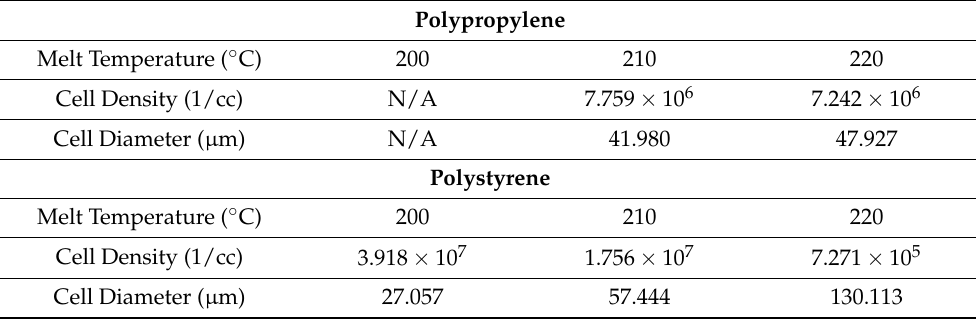
Figure 11. SEM micrographs of PP for different melt temperatures: ( a ) 200 ◦ C, ( b ) 210 ◦ C, ( c ) 220 ◦ C; SEM micrographs of PS for different melt temperatures: ( d ) 200 ◦ C, ( e ) 210 ◦ C, ( f ) 220 ◦ C. Table 7. Microscopic effects of melt temperature on the PP and PS cells as observed through the